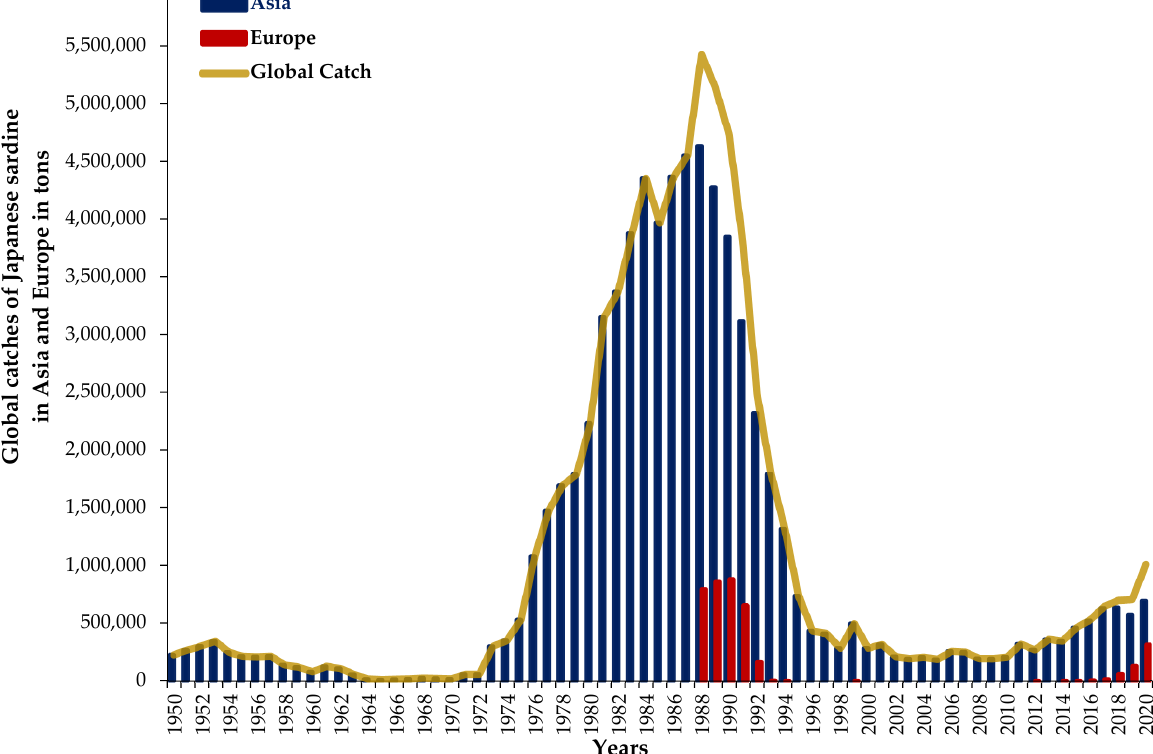
Figure 3. Evolution of global catches for Japanese sardine (Asia and Europe) from 1950 to 2020 [8,9] .